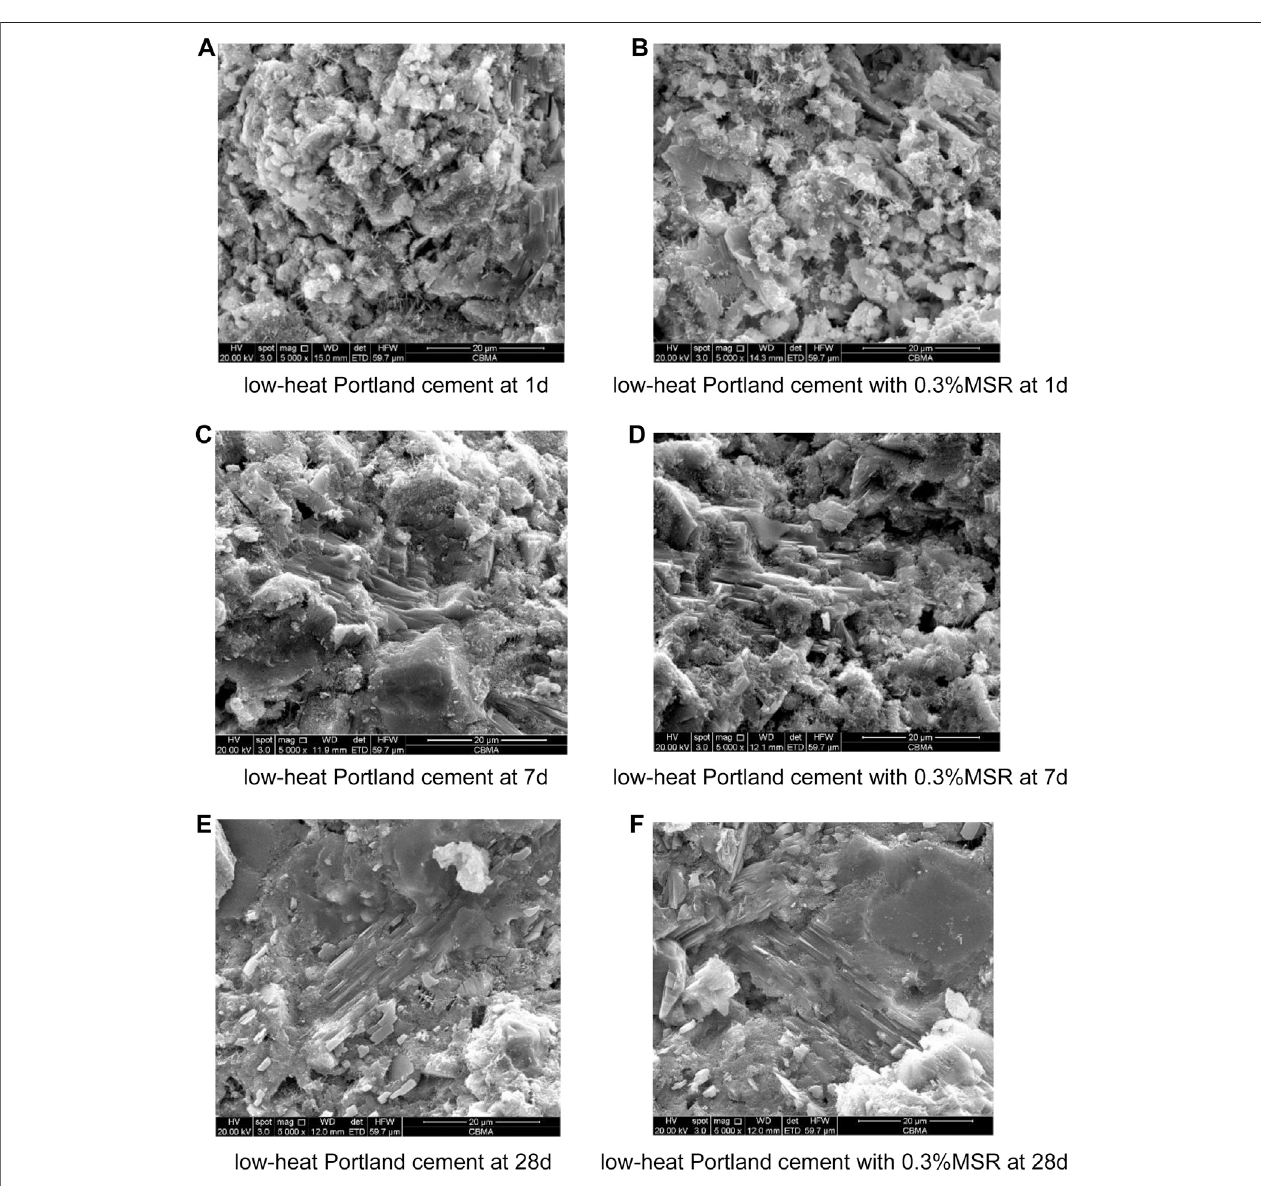
FIGURE14| SEMdiagramofhydrationproductsofcement: (A) low-heatPortlandcementat1d; (B) low-heatPortlandcementwith0.3%MSRat1d; (C) low-heat Portland cement at 7d; (D) low-heat Portland cement with 0.3% MSR at 7d; (E) low-heat Portland cement at 28d; (F) low-heat Portland cement with 0.3% MSR at 28d.